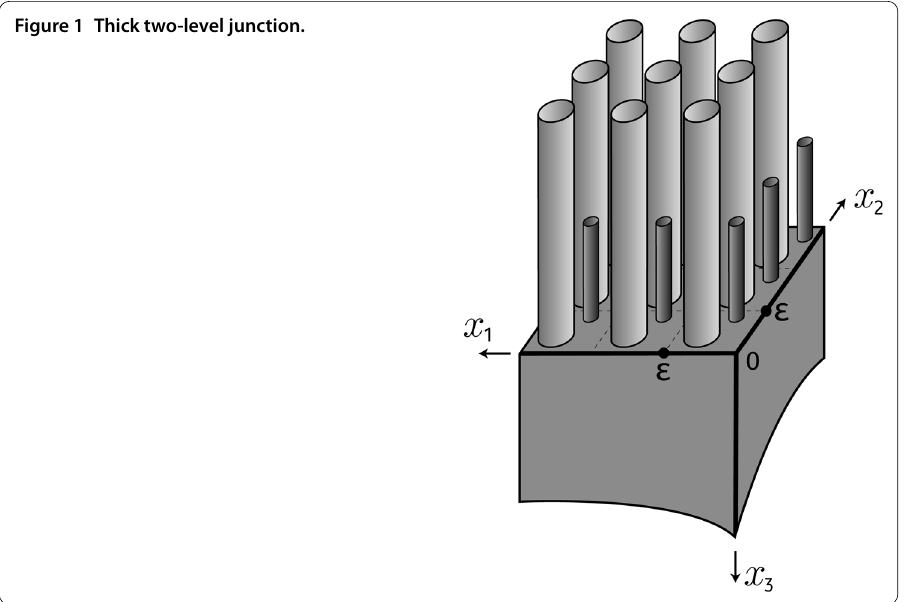
Figure 1 Thick two-level